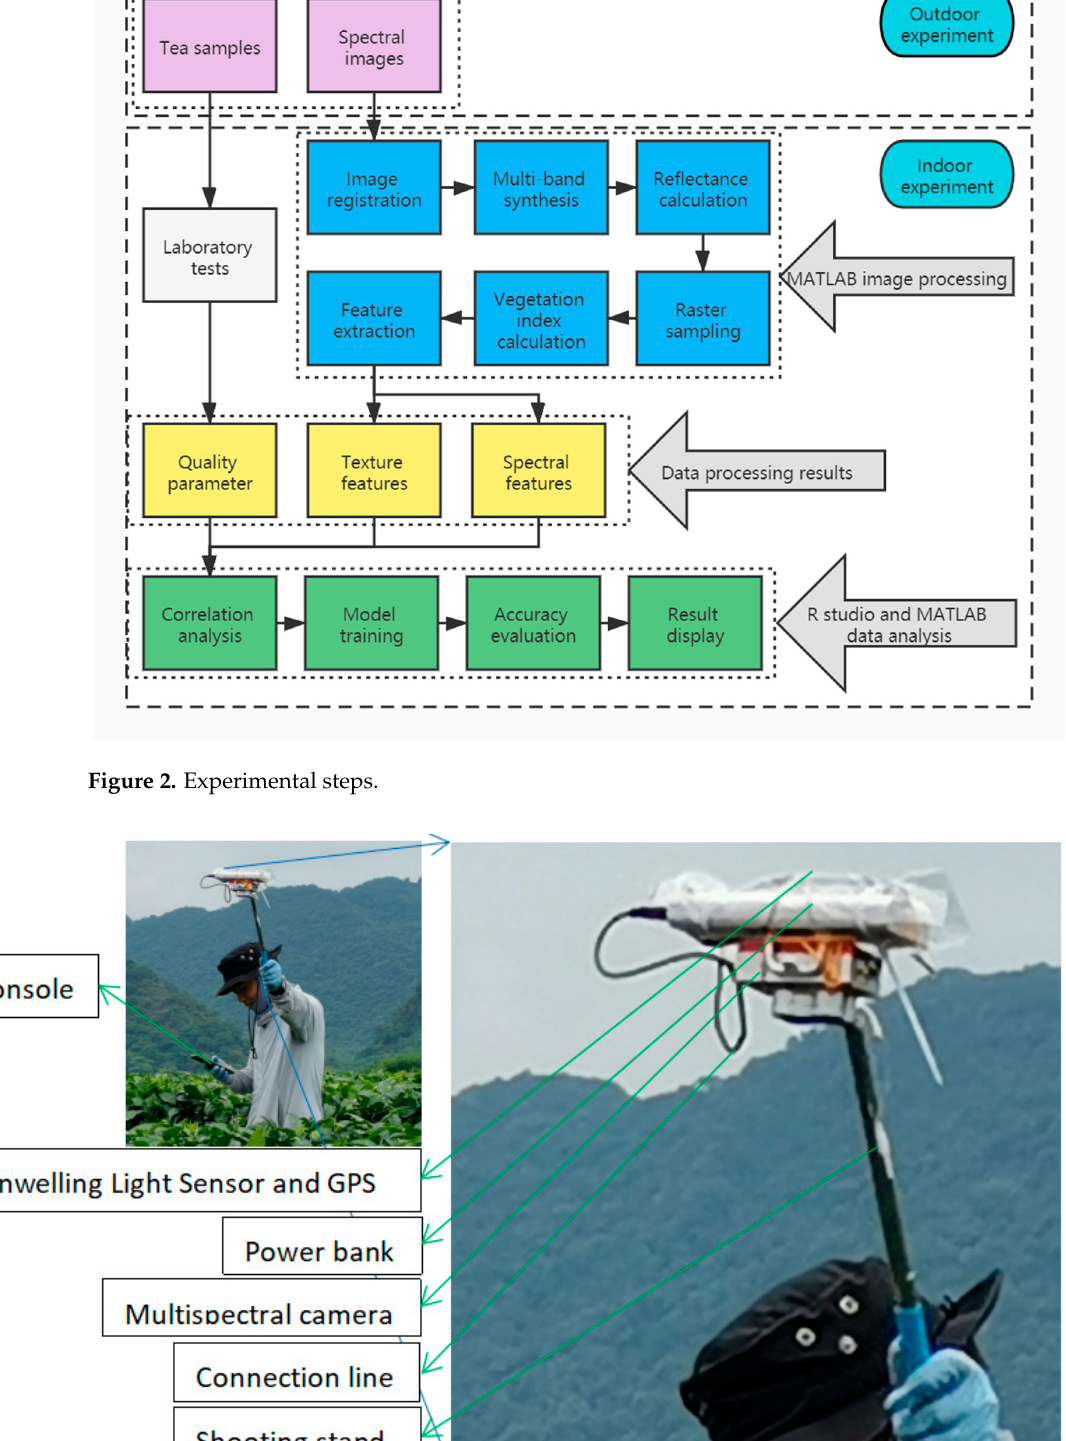
Figure 3. Data acquisition system.